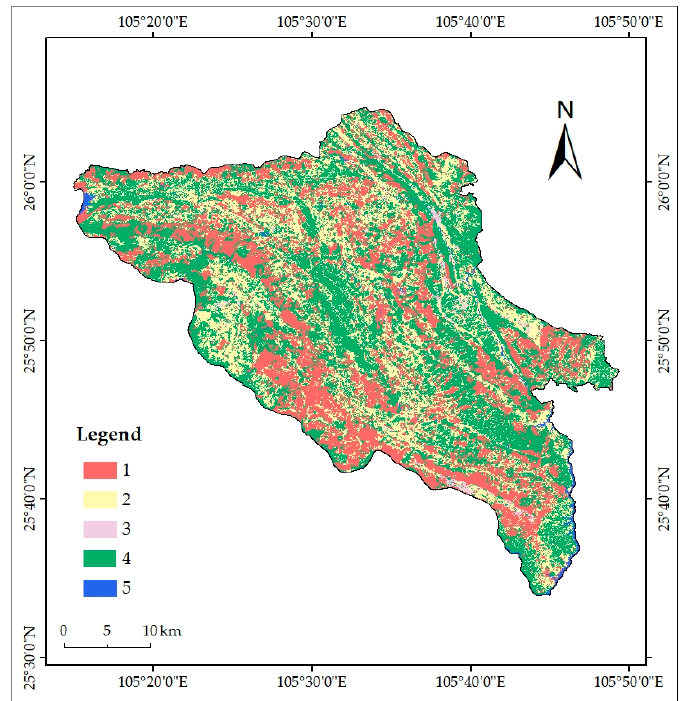
Figure 3. Importance distribution map of ecosystem services in Guanling County. Forests 2023 , 14 , x FOR PEER REVIEW